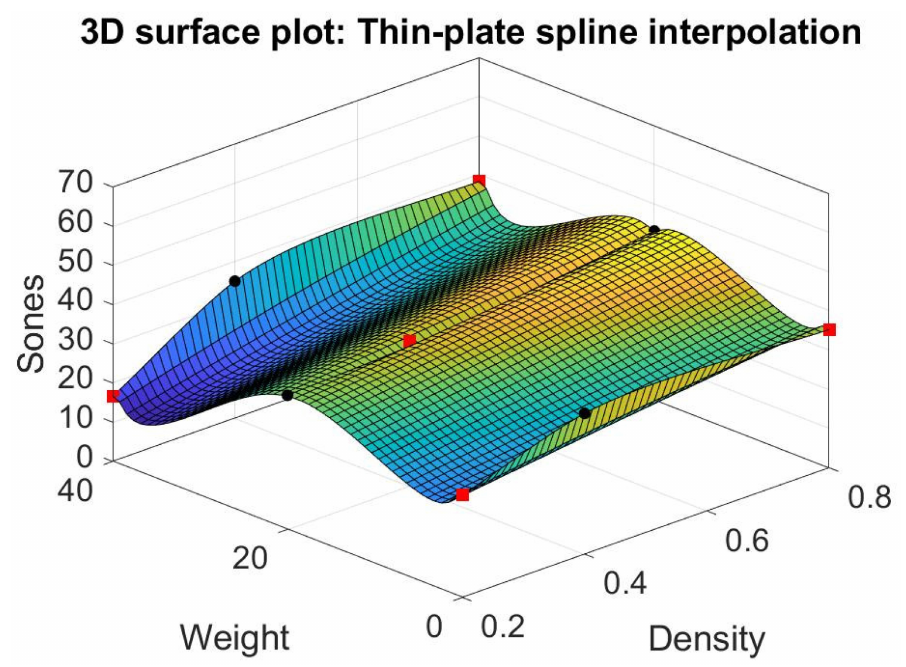
Figure 12. Thin-plate spline interpolation.